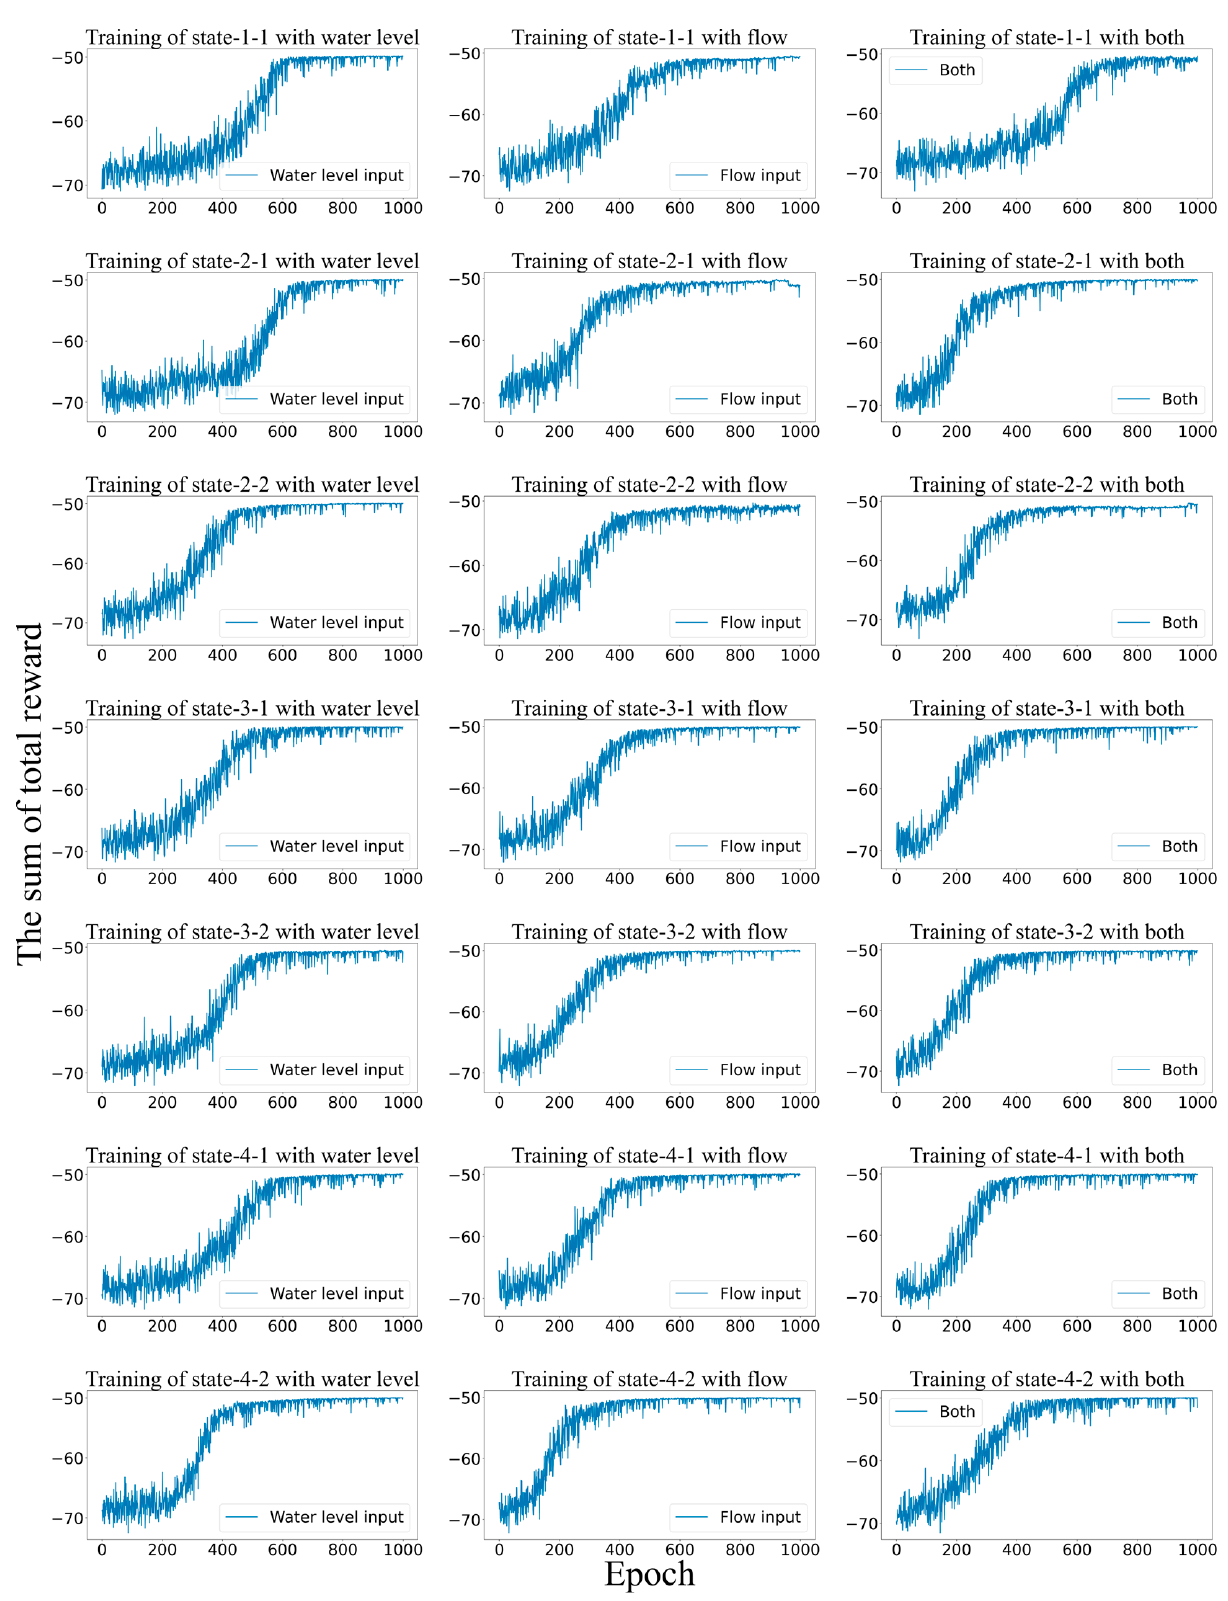
Figure 4. Training process. The reward sums of all the epochs in 10 training events.